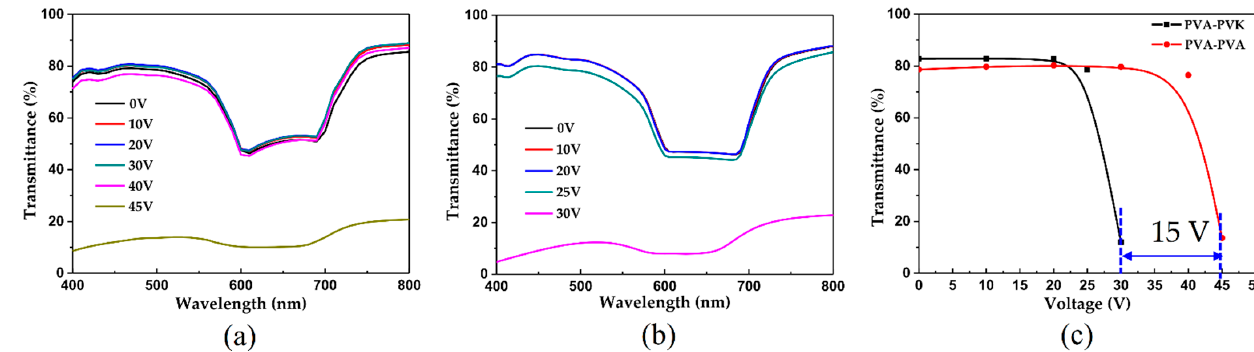
Figure 3. ( a ) Transmission spectra of the PVA–PVA cell at different applied voltages; ( b ) Transmission spectra of the PVA–PVK cell at different applied voltages; ( c ) Transmittance at 500 nm of the two cells under different applied voltages.